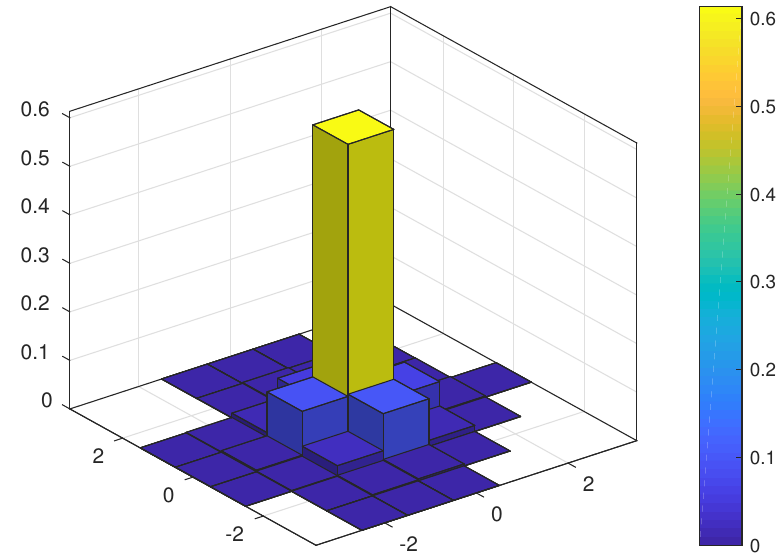
Figure 4. PMF of the TO estimation error for JMoM at E b / N 0 = 0 dB.